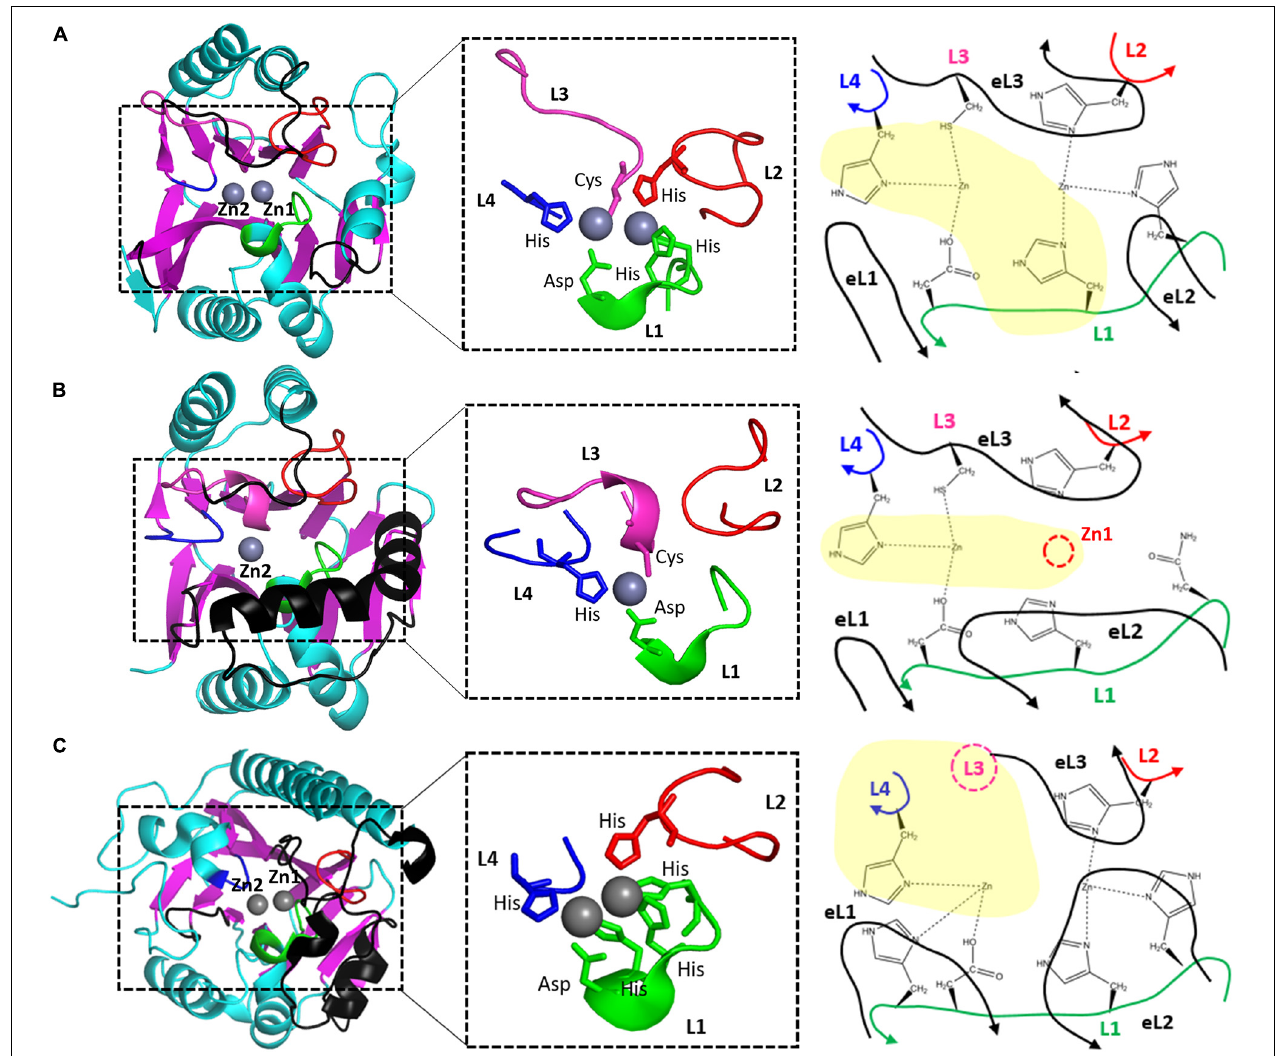
FIGURE 3 | The zinc coordination of (A) NDM-1, (B) CphA, and (C) AIM-1 as the representative B1, B2, and B3 MBLs. The schematic representations of zinc coordination are shown on the right. The four zinc-coordinating loops L1, L2, L3, and L4 are shown as green, red, pink, and blue lines, respectively. The three external loops eL1, eL2, and eL3 are shown as black lines. L3 is the N-terminal part of eL3 and is shown in black. The missing Zn1 ion and Zn2-coordinating residue from L3 are shown as red and pink dashed circles,